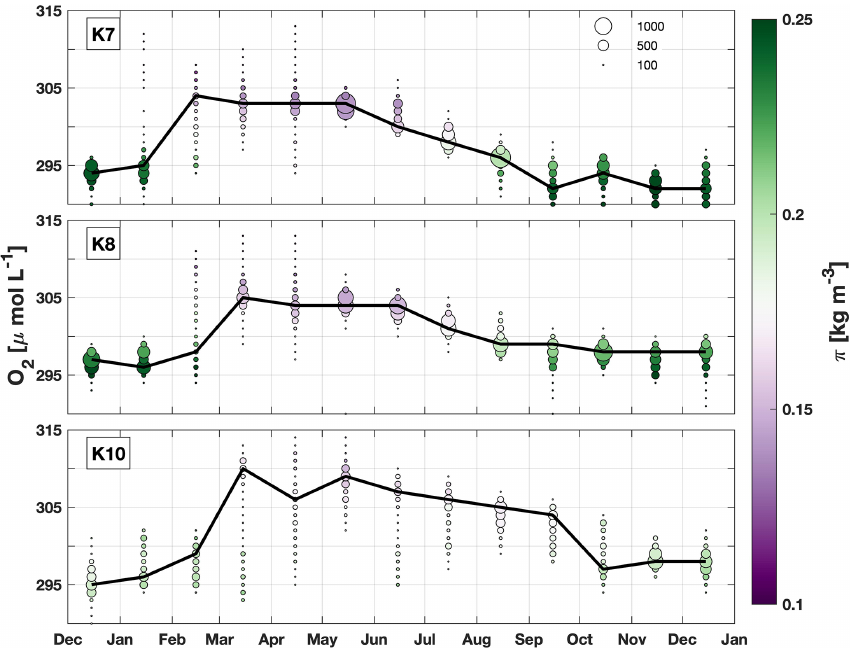
Figure 10. Monthly oxygen histograms, as in Fig. 8a, for the K7, K8, and K10 moorings. Circle size corresponds to number of observations, the black line shows the bin with the highest number of observations for each month, and colors show the mean spiciness ( π ) in each bin, highlighting the relative influence of IW and